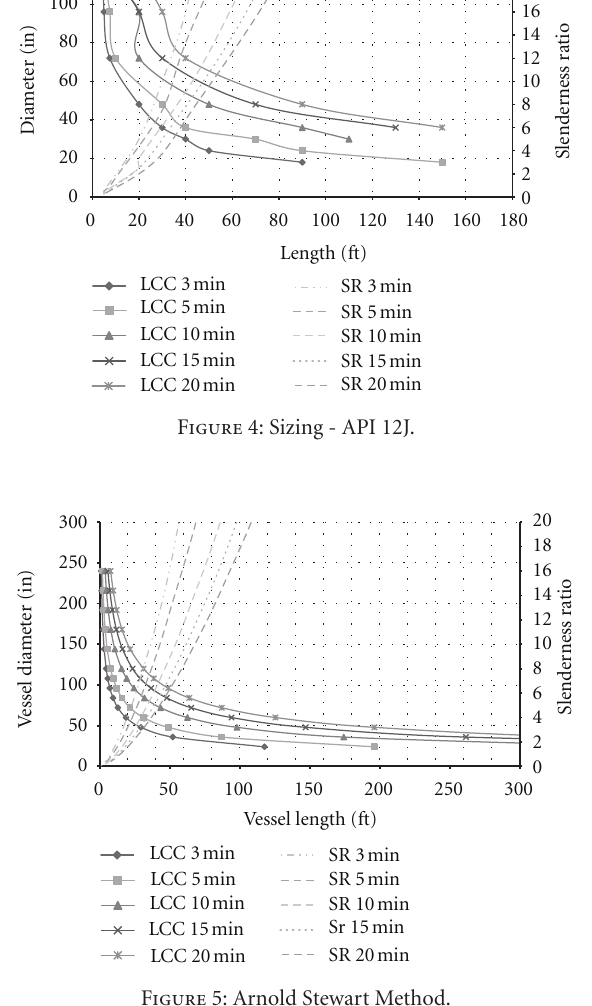
Figure 5: Arnold Stewart Method.